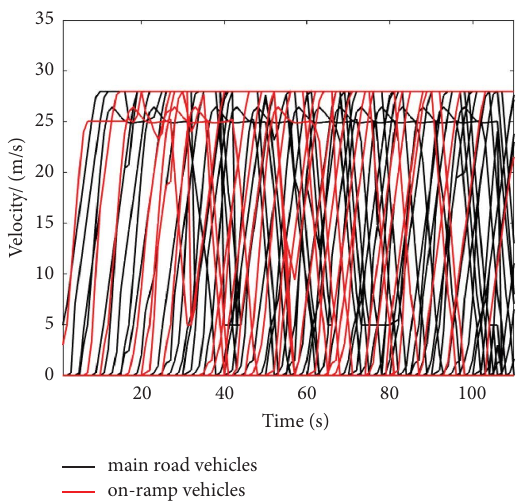
Figure 14: Vehicle speed graph without guiding.